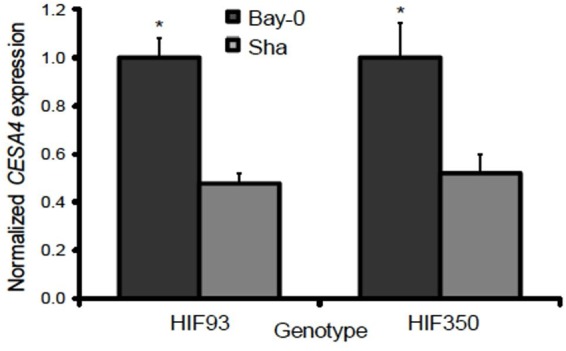
Normalized gene expression results from qPCR between heterogeneous inbred families (HIFs) segregating for parental Bay-0 and Sha alleles in CESA4 promoter region demonstrated differential binding. Transcript abundance in developing stems containing CESA4Bay was twofold greater than that of CESA4Sha in both pairs of NILs. ∗P < 0.01.